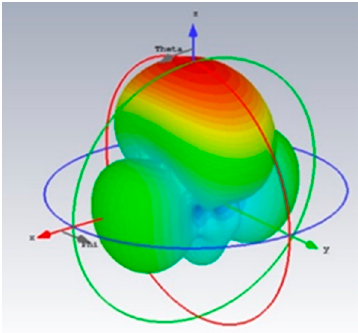
Figure 2. The three-dimensional radiation pattern of the dipole array antenna used in the system.